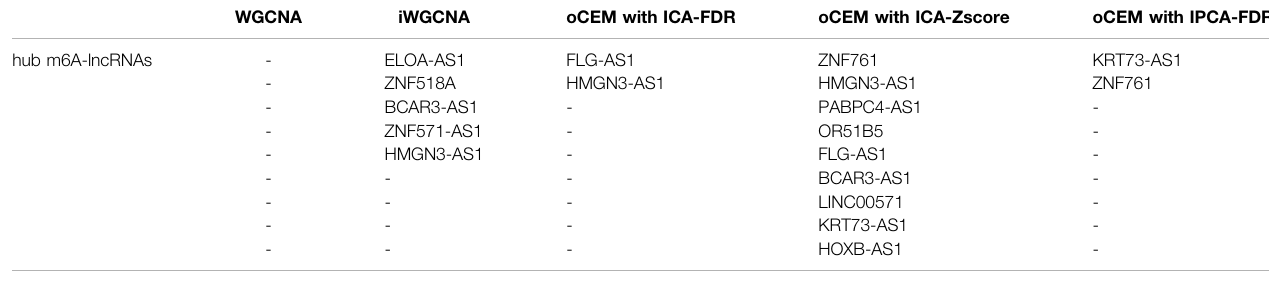
TABLE 2 | A set of 13 hub m6A-lncRNAs predicted by the three co-expressed module identi fi cation tools, including WGCNA, iWGCNA, and the three variations of oCEM.